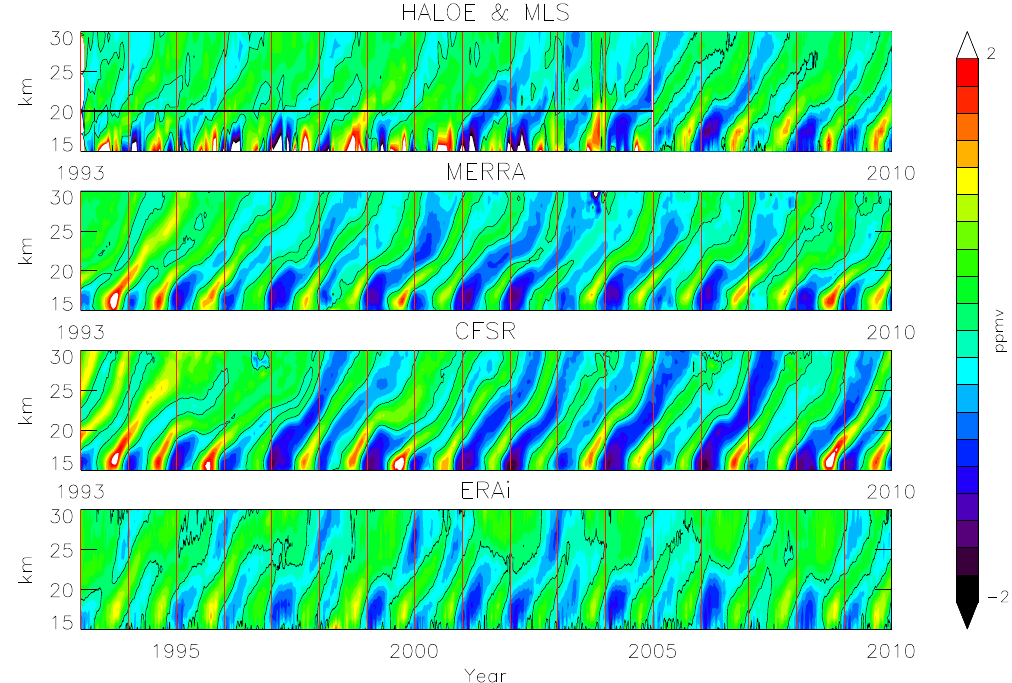
Fig. 7. Water vapor anomalies at the equator from 1993 to 2010. Top, HALOE and MLS combined (HALOE before 2005 – dark line). Top-middle MERRA, bottom middle CFSR, bottom,